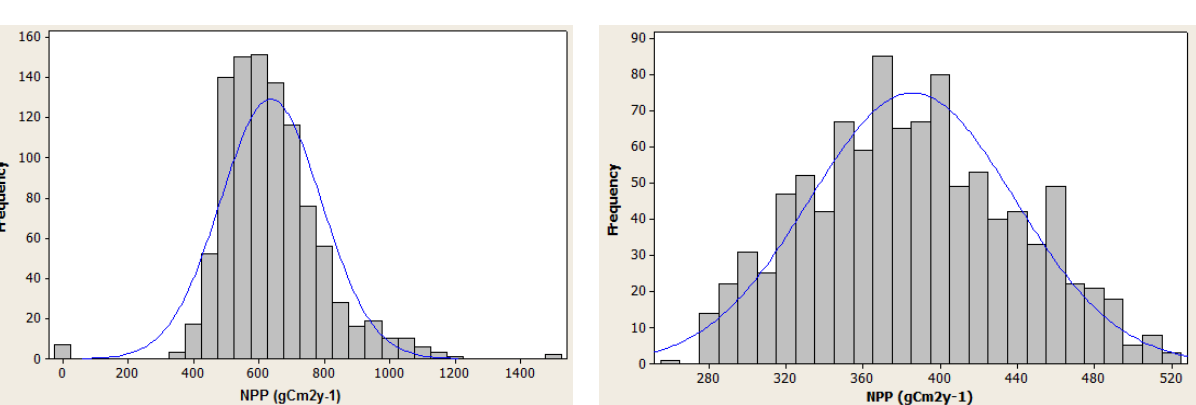
Figure 8. Histograms of CASA (Left) and LPJ-GUESS (Right) NPP maps